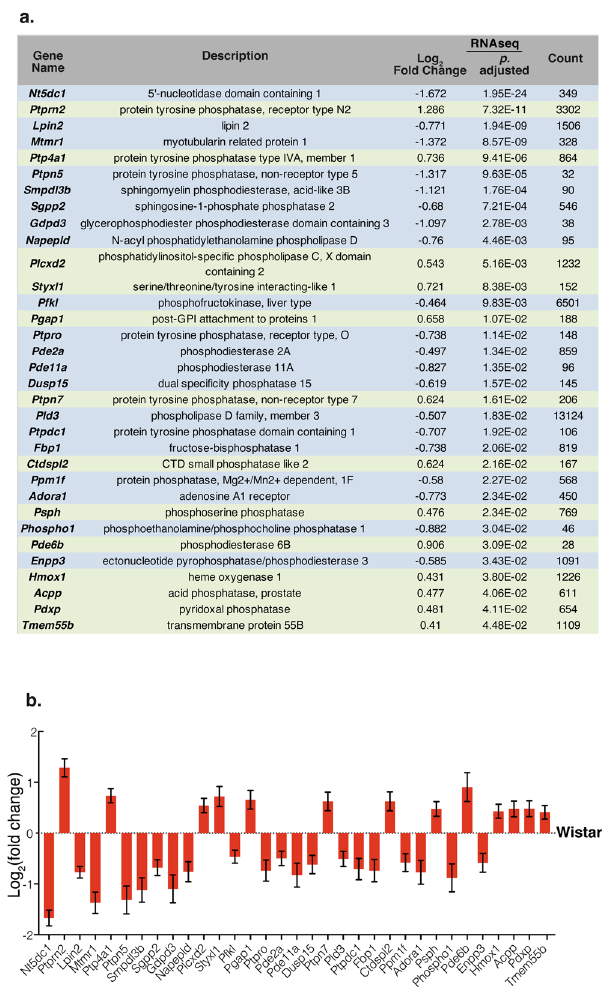
Figure 5. Phosphoric Ester Hydrolase Activity GO Group (GO:0042578). The differentially expressed genes in the MF GO group ‘phosphoric ester hydrolase activity’ (GO:0042578) are listed, where green and blue